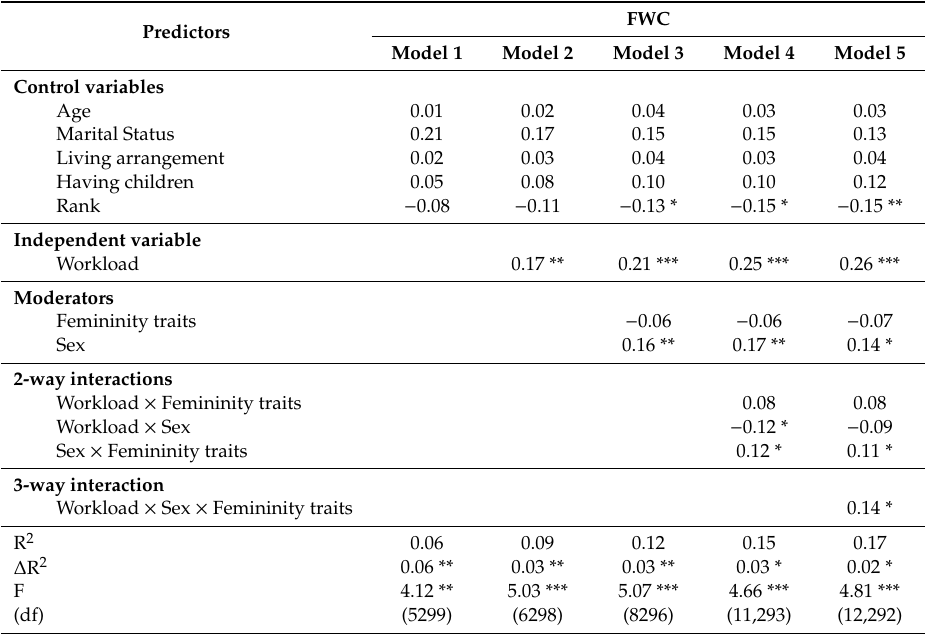
Table 3. Results of moderated regression on FWC: femininity traits.